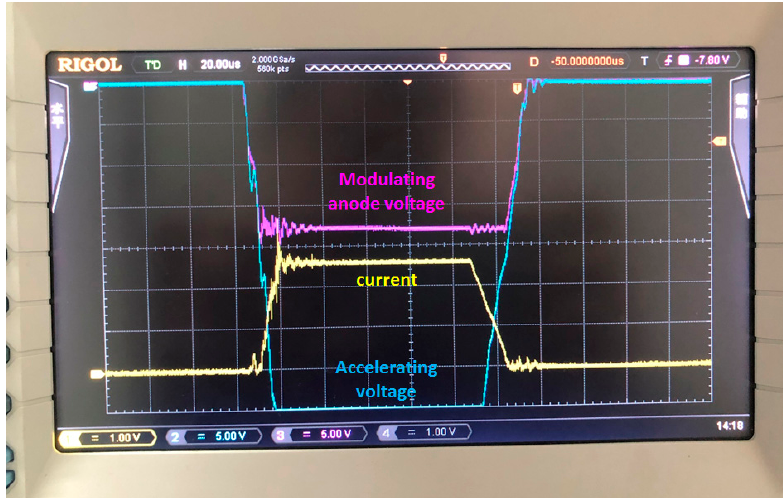
Figure 15. Measured voltage (modulating anode and main anode) and current of the 170 GHz gy-